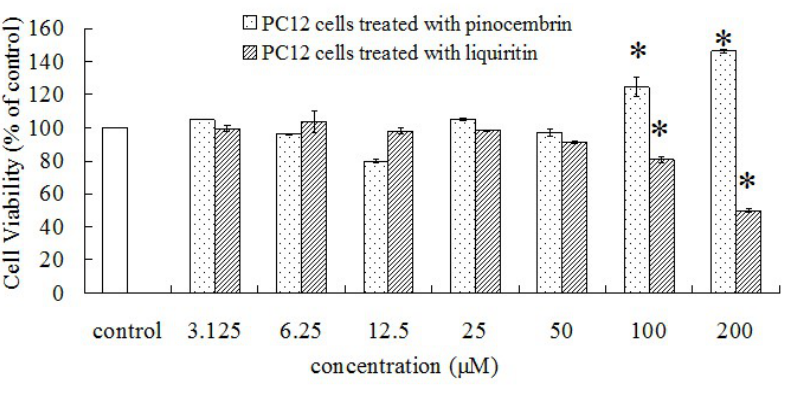
Figure 2. Protective effect on H any treatment. ( a ) the cytotoxicity of the pinocembrin and liquiritin on cell viability in normal cells. * p < 0.01, significant differences between treatment groups and negative control group. ( b ) the protective effects of the pinocembrin and liquiritin on H oxidative damage on PC12 cells. * p < 0.01, significant differences between pretreatment with pinocembrin or liquiritin groups and H